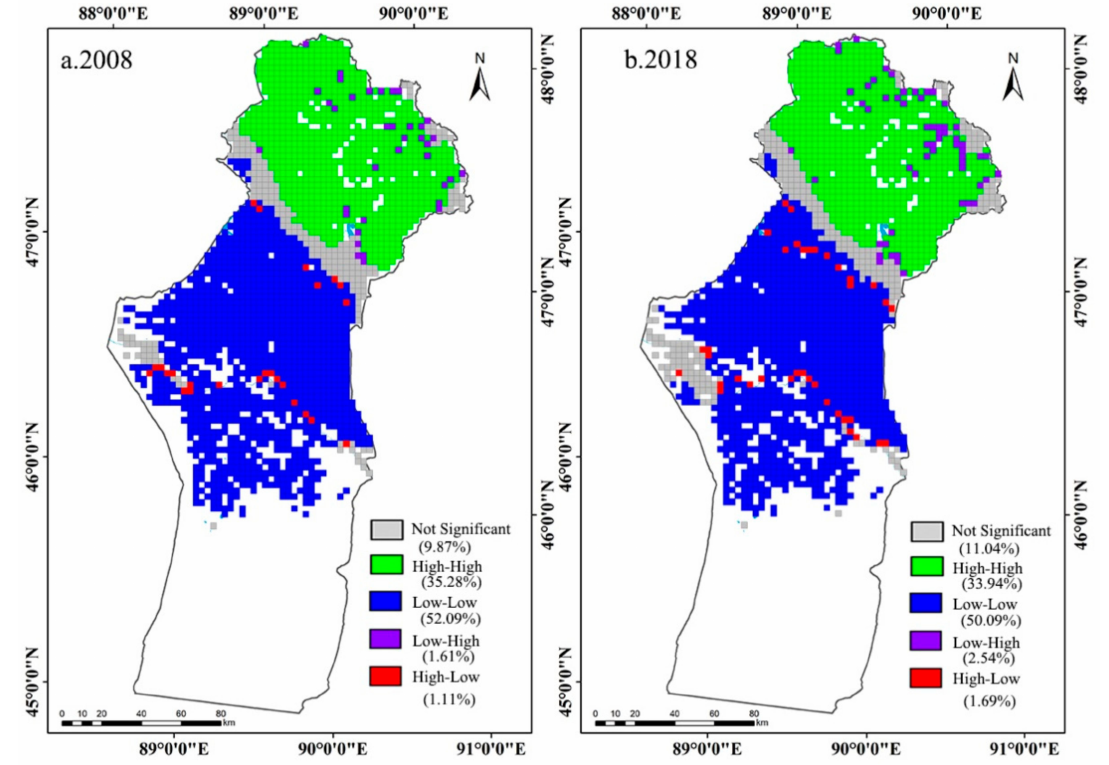
Figure 4. LISA aggregation map of MODEI in Fuyun County.